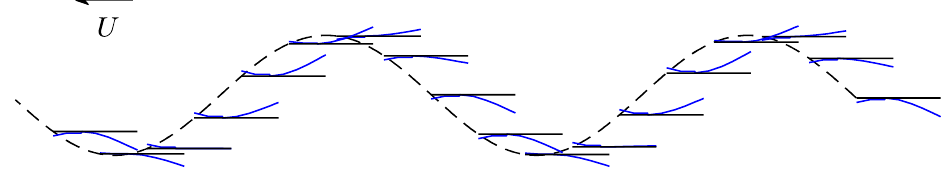
Figure 16. Typical configurations of the un-deformed (black) and deformable camber line (blue curves) on the trajectory of the leading edge (LE; dashed line) for a purely heaving foil.